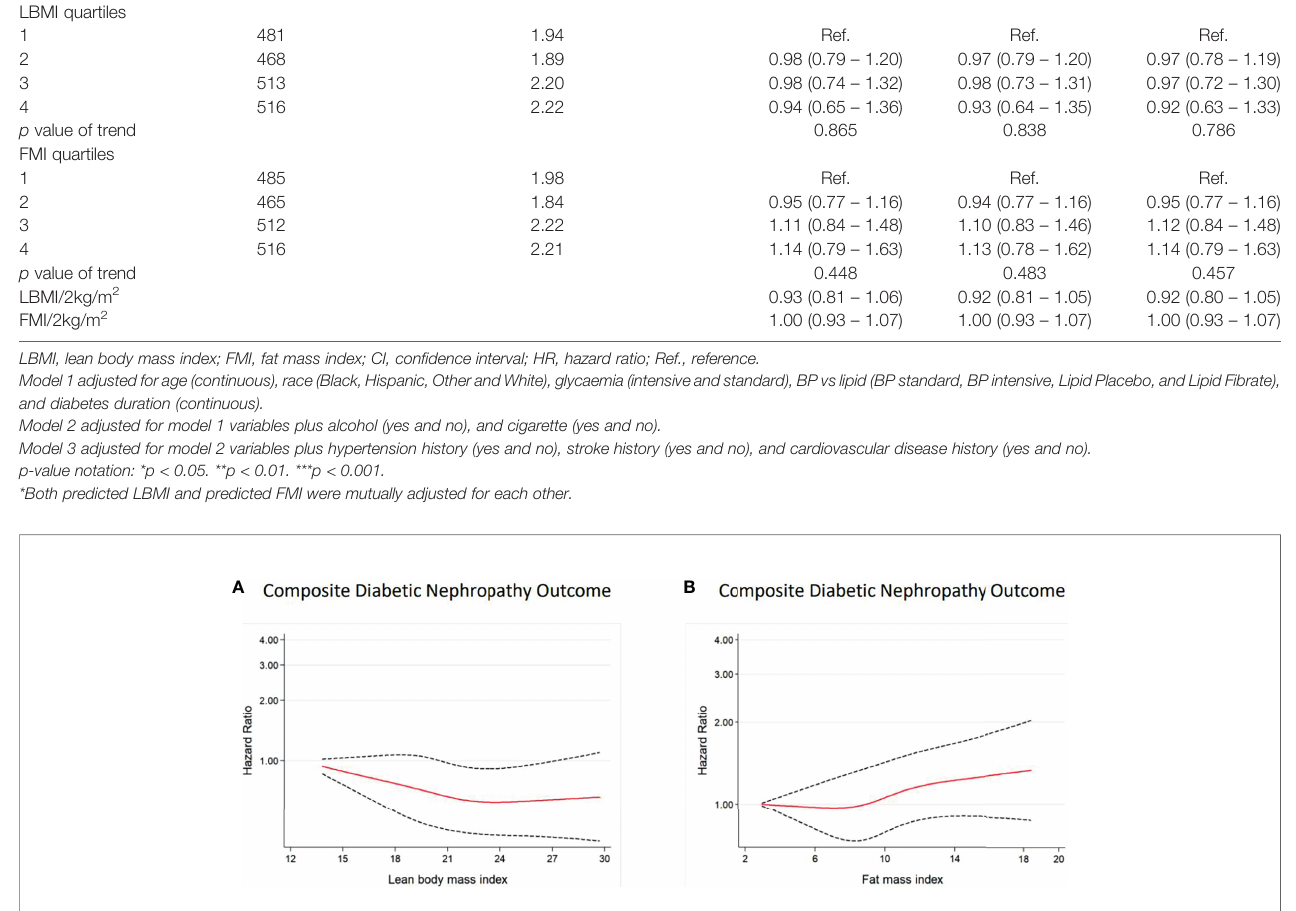
FIGURE 2 | Multivariable-adjusted hazard ratios of incident DN for predicted LBMI (A) and predicted FMI (B) among men with diabetes. Curves represent adjusted hazard ratios for DN based on restricted cubic splines with knots placed at 5th, 35th, 50th, 65th, and 95th centiles. Models were adjusted for baseline age, race, glycaemia, BP vs lipid, diabetes duration, alcohol, cigarette, hypertension history, stroke history, and CVD history. Predicted LBMI and predicted FMI were mutually adjusted. The solid red line represents the hazard ratio, and the dashed black lines represent the 95% con fi dence intervals for the association between LBMI or FMI and DN composite